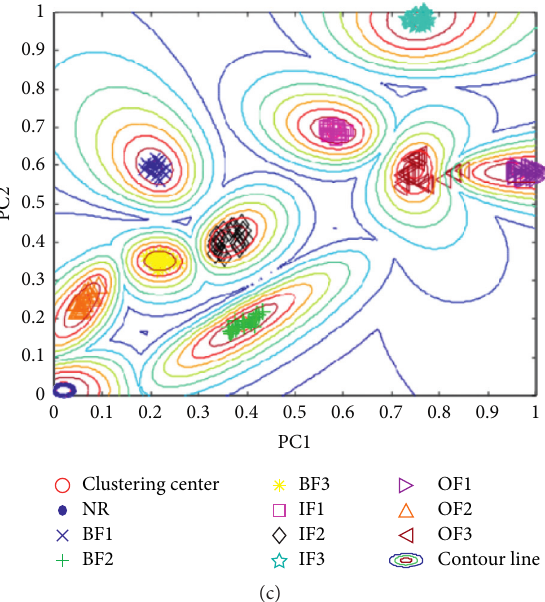
Figure 9: Recognition results under different loads. (a) 0hp; (b) 2hp; (c) 3 hp.